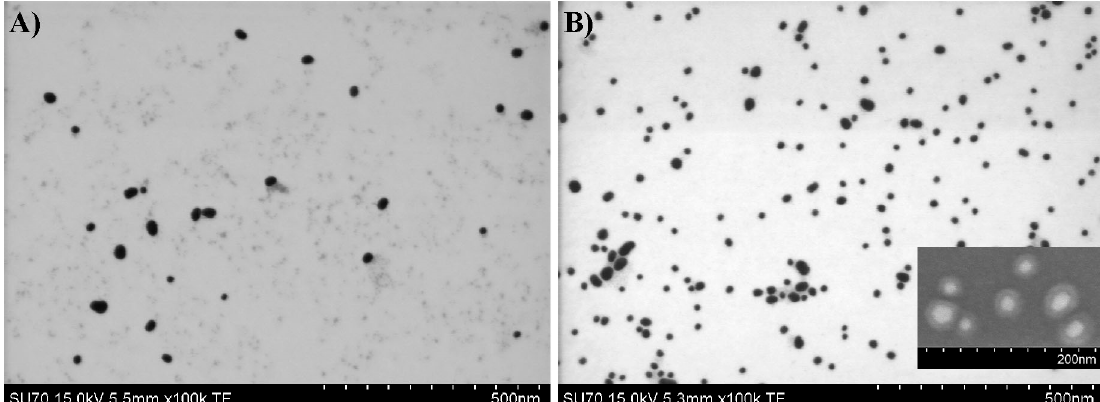
Figure 4. Scanning Electron Microscopy (SEM) in transmission mode (STEM) images of Au